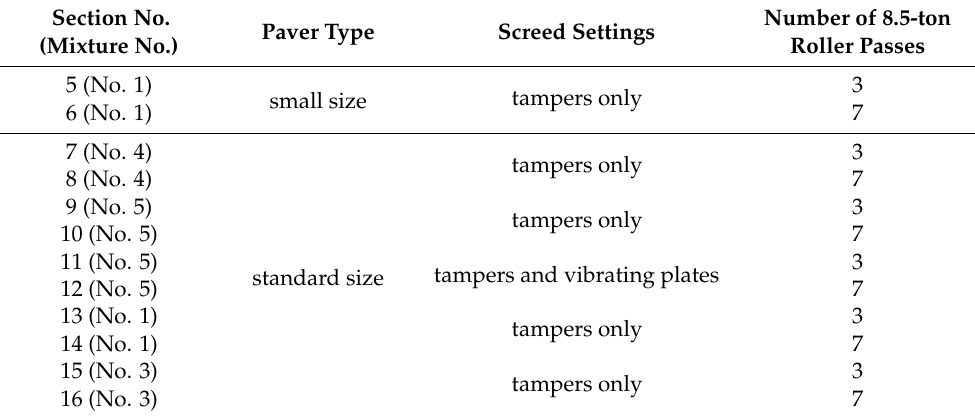
Table 3. Combinations of mixture variants and construction factors.